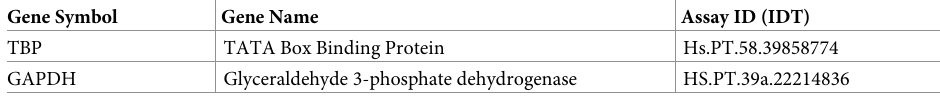
Table 3. Predesigned primer sets for PrimeTime ™ standard qPCR